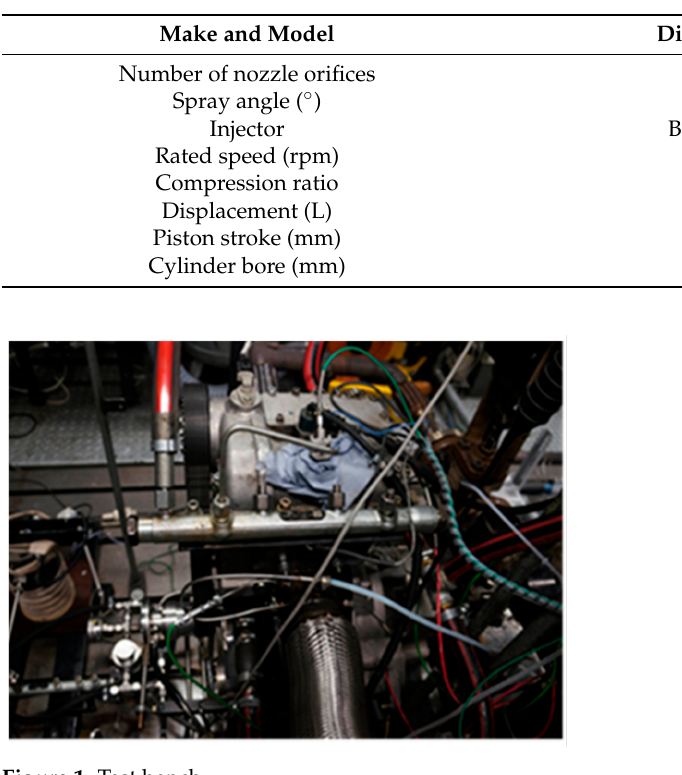
Table 1. Specifications of the actual engine.